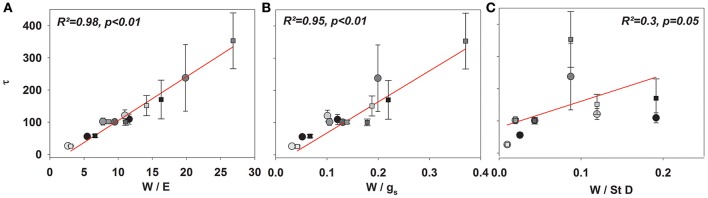
Mean τ (Equation 8) across all species subsequent to a drop to 30% (circles) and an increase to 60% rH (squares) against W/E (A), W/gs
(B), and W/stomatal density (C).